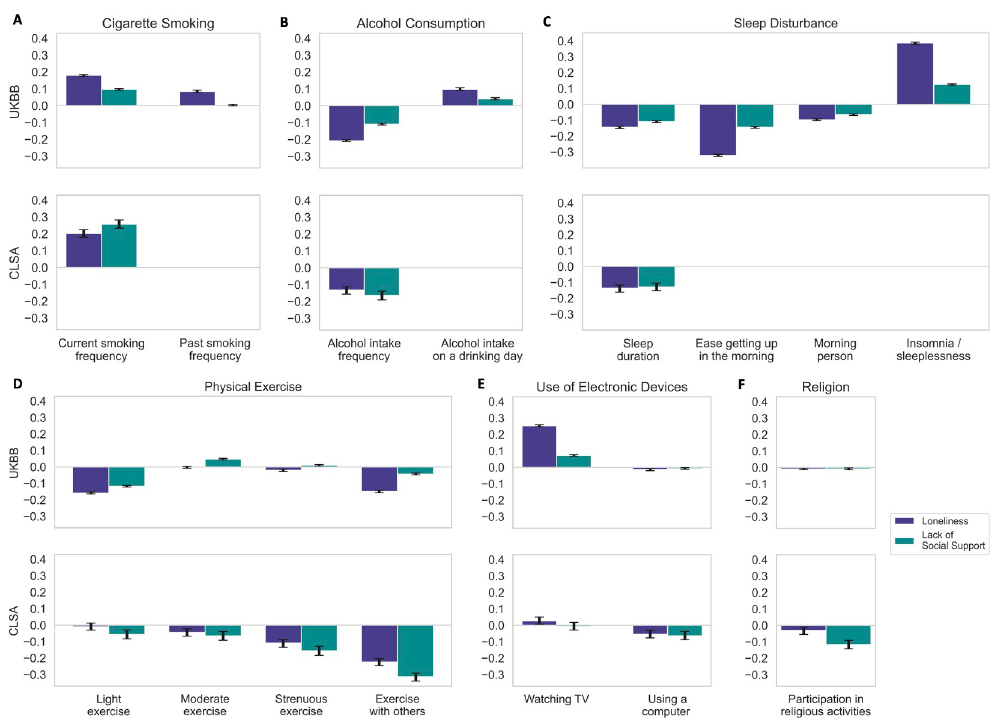
Fig 2. Various ADRD-related lifestyle factors show strong association effects with loneliness and lack of social support across both cohorts. Bayesian estimation of the posterior probability that a given risk factor relates to one of two measures of social deprivation: loneliness and lack of social support. All target risk factor variables were z-scored prior to running the Bayesian models. For simplicity, results are expressed as the mean and the 90% highest posterior density interval of the model coefficients (black error bars). In both UKBB and the CLSA, loneliness and lack of social support are robustly associated with a variety of lifestyle factors, including (A) current cigarette smoking, (B) alcohol consumption, (C) sleep duration, and (D) participation in physical activities with others. (E) Use of electronic devices and (F) participation in religious activities show smaller links to loneliness and weak social support. Both subjective and objective social isolation follow similar patterns in their associations with behavioural traits across the two cohorts. Sleeplessness has the largest association with social isolation in this